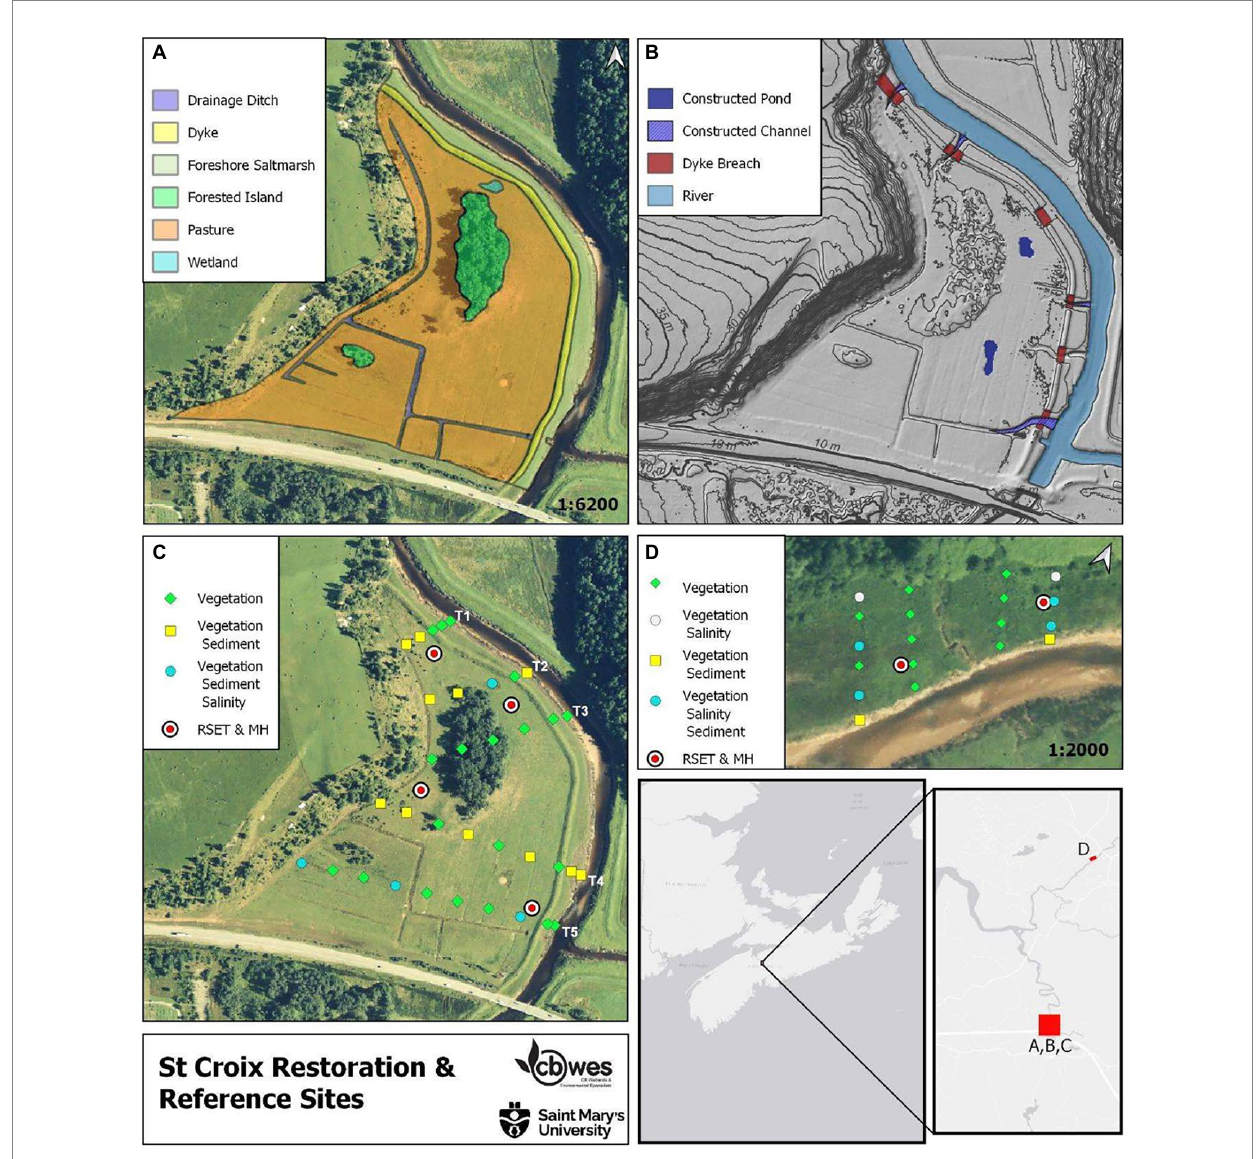
FIGURE 1 St. Croix site (A) Pre-restoration habitat map; (B) Restoration plan; (C) Sampling locations; (D) Reference site.